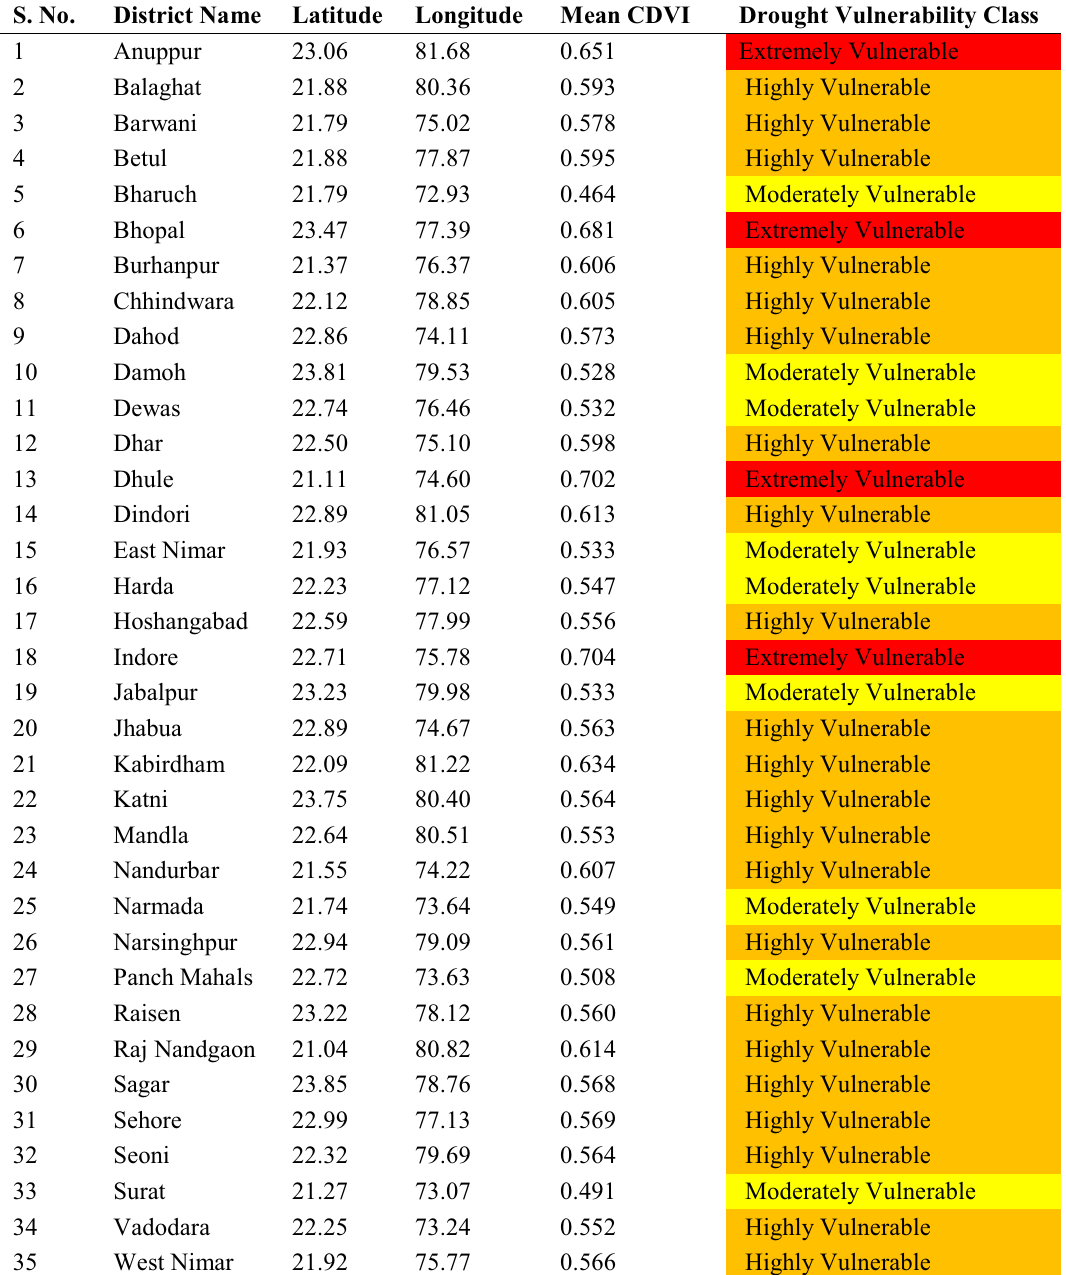
Table 5 District-wise CDVI-based drought vulnerability classification over Narmada River Basin S.